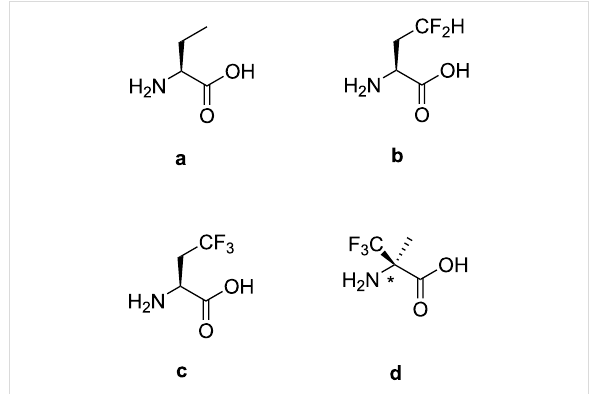
Figure 2: Structures of non-canonical amino acids. a. ( S )-ethylglycine, b. ( S )-2-amino-4,4-difluorobutanoic acid, c. ( S )-2-amino-4,4,4- trifluorobutanoic acid, d. ( RS )-2-amino-2-methyl-3,3,3-trifluoropro- panoic